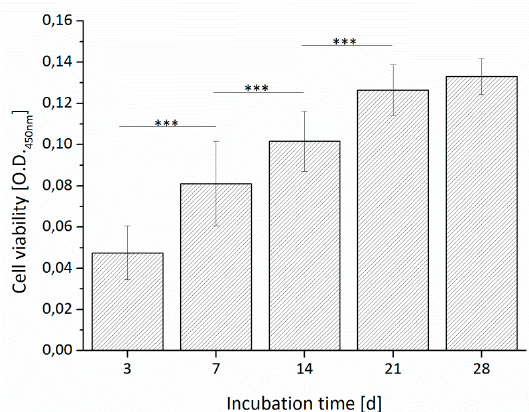
Figure 11. Cell viability of a PCL-PEG 7030 ADA-GEL construct with ST2 cells up to 28 days of incubation. Asterisks denote significant difference of pairwise comparison. *** p < 0.001.